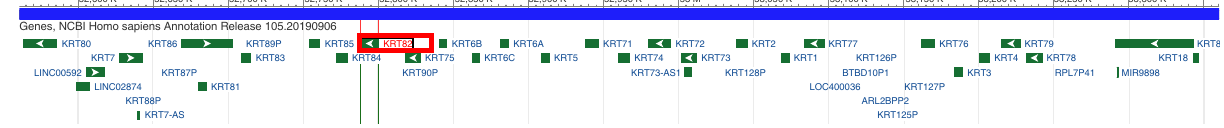
Fig. 4 Type II keratin genes cluster together on Ch12. 700 kb chromosomal locus encompassing the type II keratin gene cluster (green bars) on chromosome 12. KRT82 is boxed, in